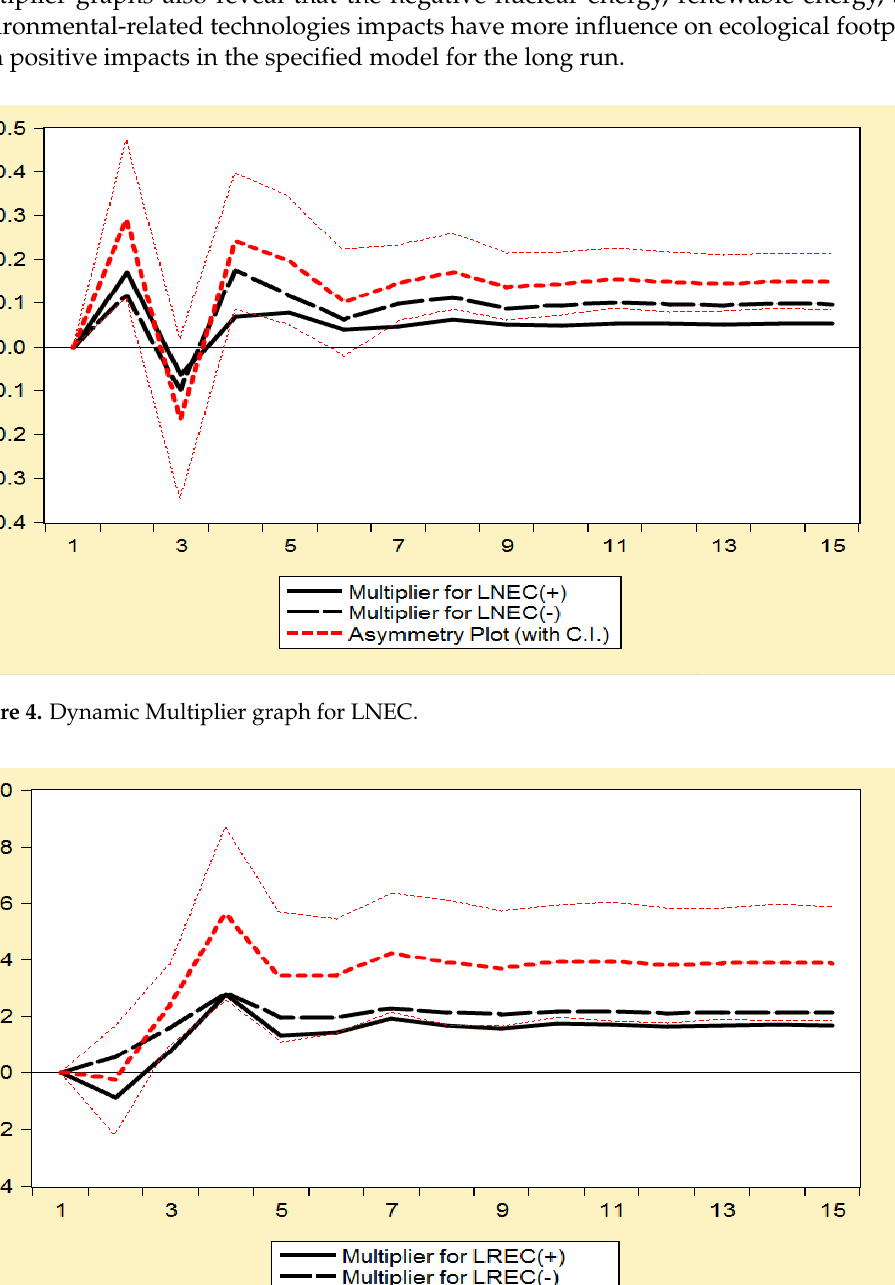
Figure 6. Dynamic Multiplier graph for LZERT. 4.6. Sensitivity Analysis Table 11 provides detailed information about the reliability/sensitivity tests of the study model. According to the findings of Table 11, the ARCH and Brush–Pagan–Godfrey tests show the study model is free of the heteroscedasticity issue, which verifies that the error term of the model follows the homogeneous distribution. Moreover, the finding of the Breusch–Godfrey LM tests reveals that our model is also free of autocorrelation set- backs. Furthermore, the F-statistics and p -value of the Jarque–Bera normality test verifies that the data is perfectly normally distributed. At the same time, the Ramsey RESET test for model specification shows that the study model is well specified for our estimation.